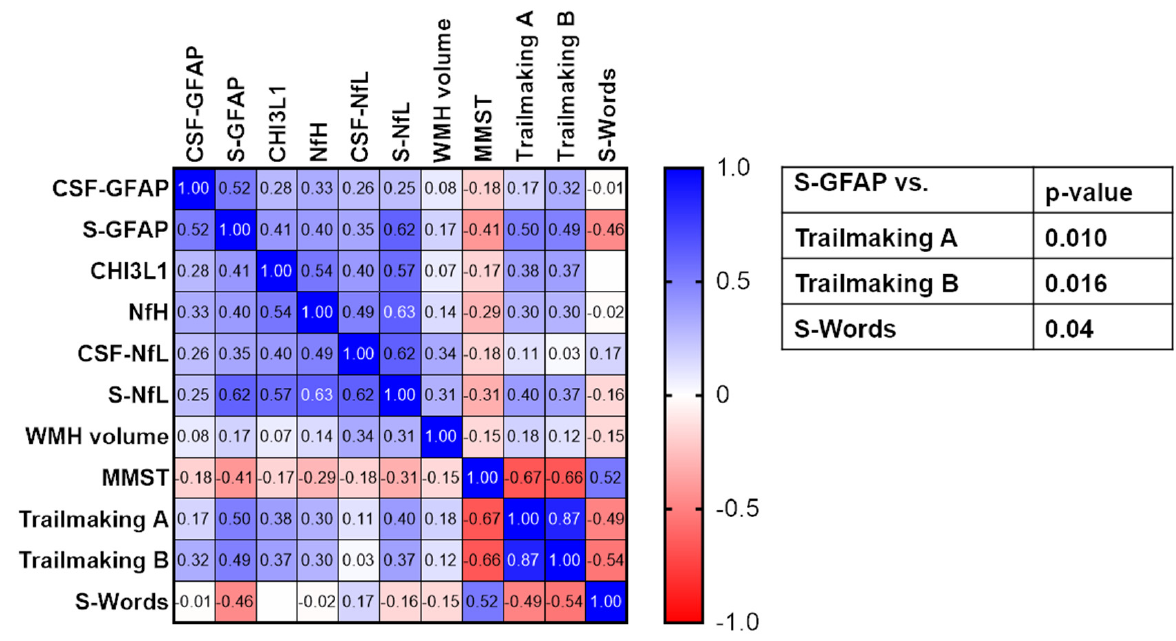
Figure 4. NIHSS (0, 1, 2 and ≥ 3) compared to WMH, NfL (CSF and serum), GFAP (CSF and serum),